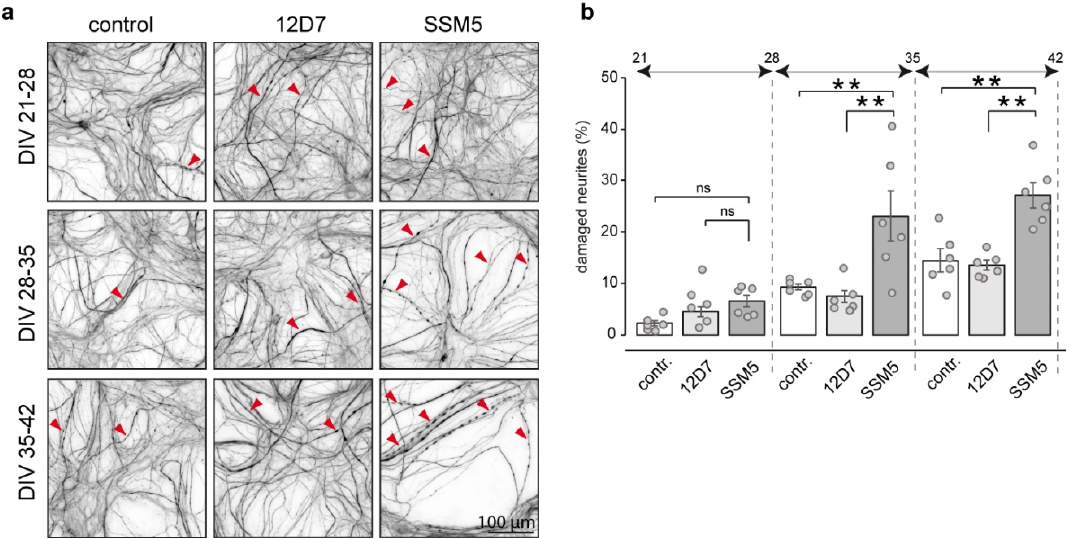
Figure 4. Treatment with SSM5 affects neurite integrity and leads to neurite swelling and fragmen ‐ tation. ( a ) Sample images of non ‐ treated control cultures (left panels), vs. cultures treated for one week with 12D7 (middle panels) or SSM5 (right panels) and immunostained for NF200 (grey). Red arrowheads indicate affected neuronal processes. Scale bar: 100 μ m. ( b ) Quantification of damaged neurites. Data show the percentage of processes exhibiting morphological abnormalities (swelling, fragmentation) of total number of neurites. Three independent experiments (technical replicates = 2), Mean ± SEM. One ‐ way ANOVA with Tukey multiple comparison showed significant differences between SSM5 vs. 12D7 vs. control groups only when treatment was performed in late cultures (DIV 28–42); ns, non ‐ significant; ** p < 0.01.